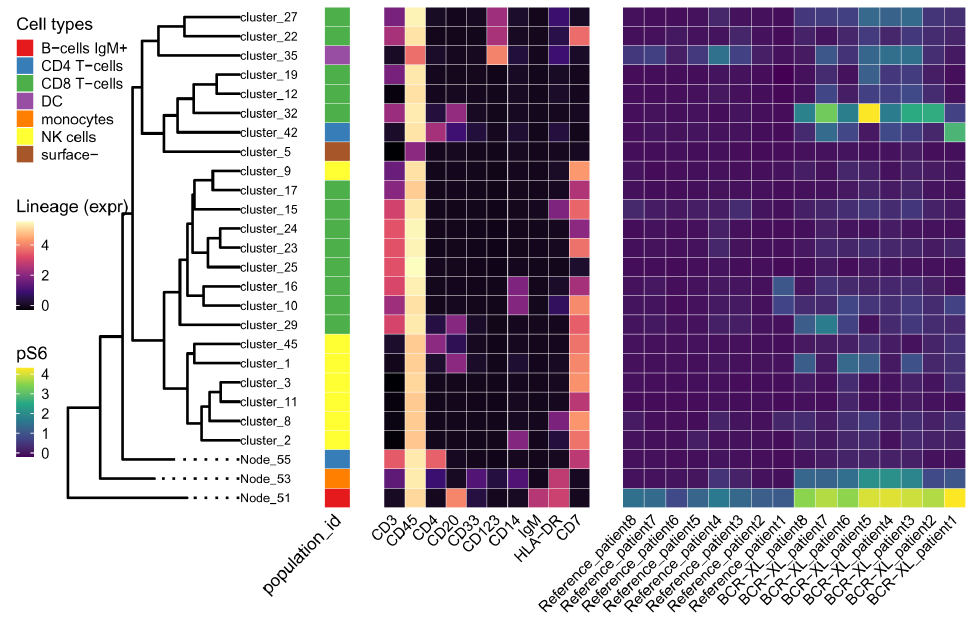
Figure 14. The median expression of markers across 26 cell clusters. This figure is similar to Figure 12 except that B cells (Node_51) , monocytes (Node_53) and CD4 T-cells (Node_55) are now visualized at a broader resolution.